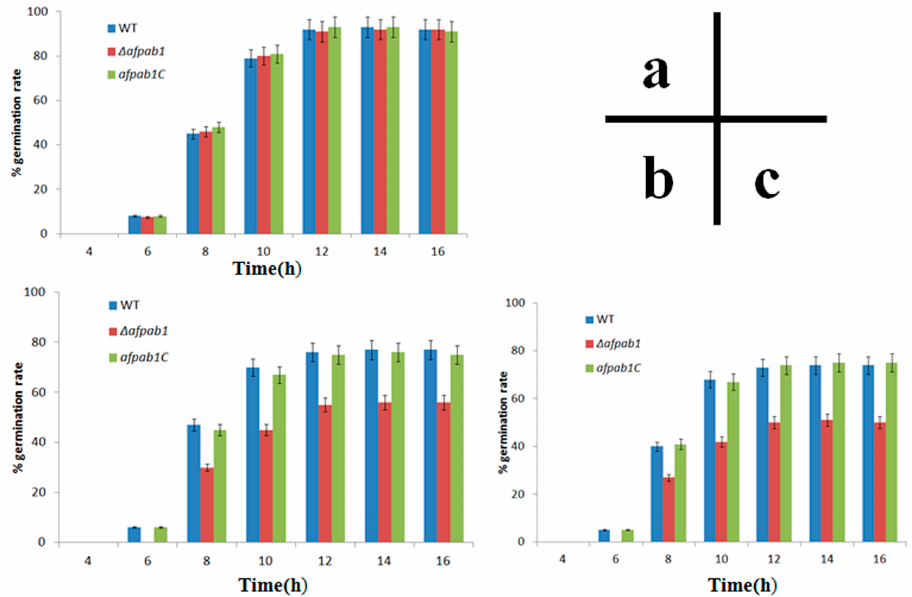
Figure 7. Germination rates of afpab1 deletion strain compared with WT and afpab1C under control, 3 mM H 2 O 2 or 15 µM menadione. Data shown (means ± SD) are from three independent experiments for each strain. ( a ) Control; ( b ) H 2 O 2 ; ( c ) Menadione.